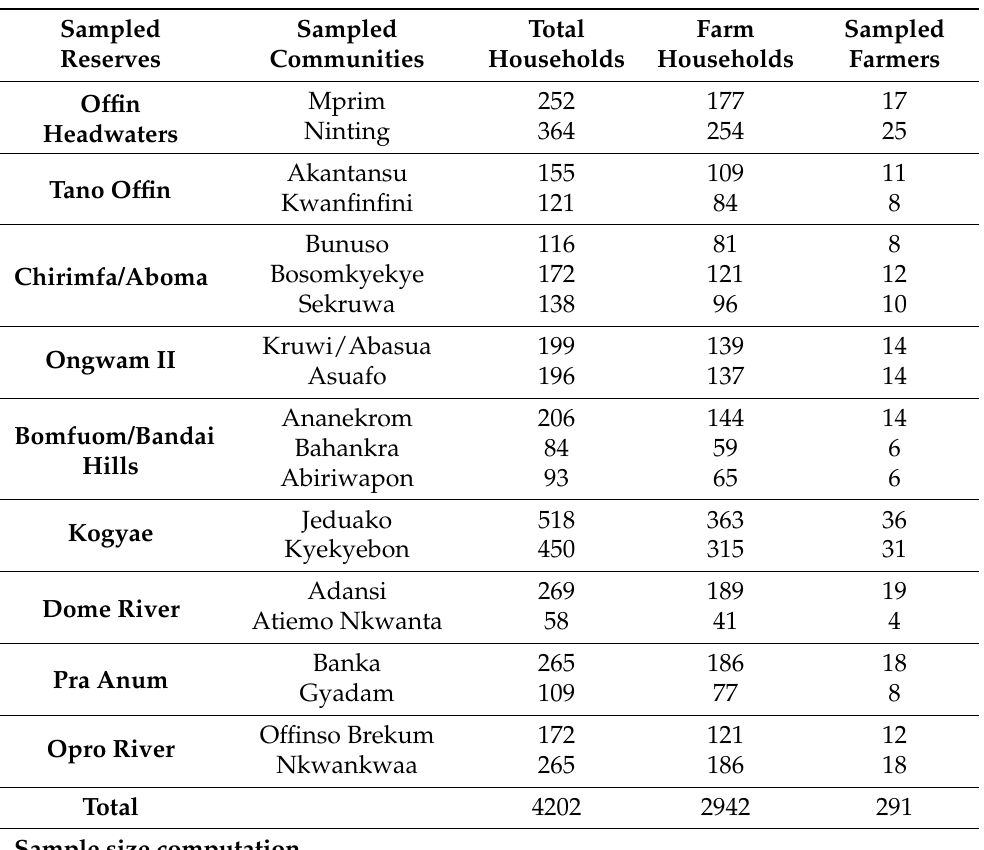
Table A1. Sampled reserves, communities and farmers used for the study. Source: GSS 2014;